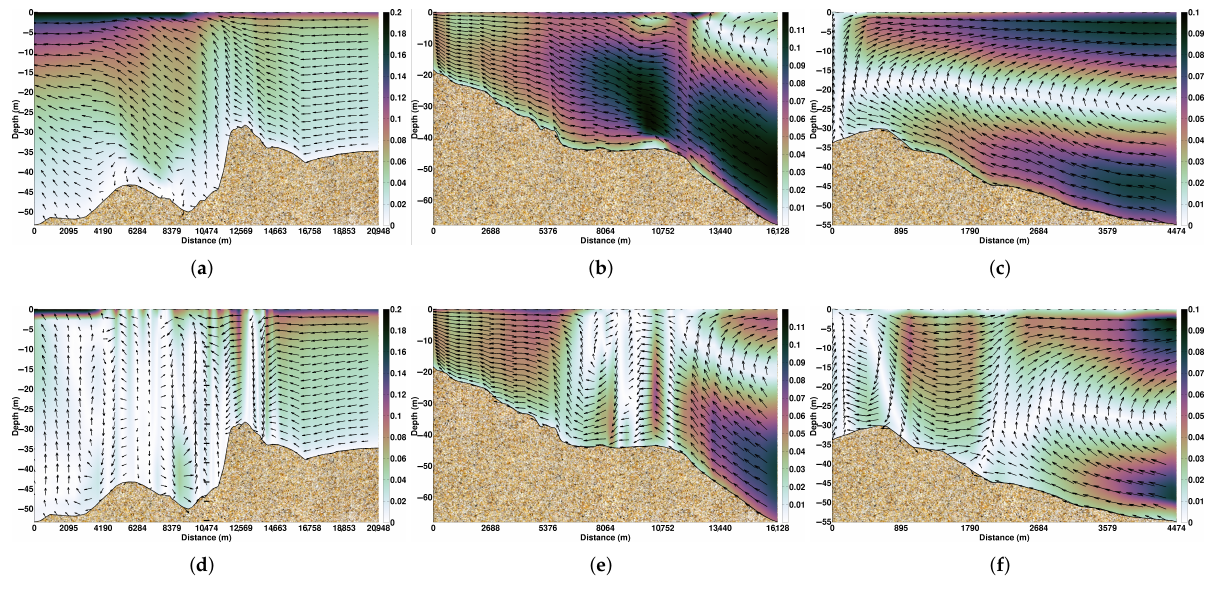
Figure 10. Vertical cross sections for the São Paulo turbines site; colored surface shows mean velocity (m · s − 1 ) while vectors show direction. Simulation without the presence of turbines (upper panel) and with the turbines (lower panel). ( a , d ) Refers to SP1 transect; ( b , e ) refers to SP2 transect; ( c , f ) refers to SP3 transect. See Figure 1c. for a better location of the